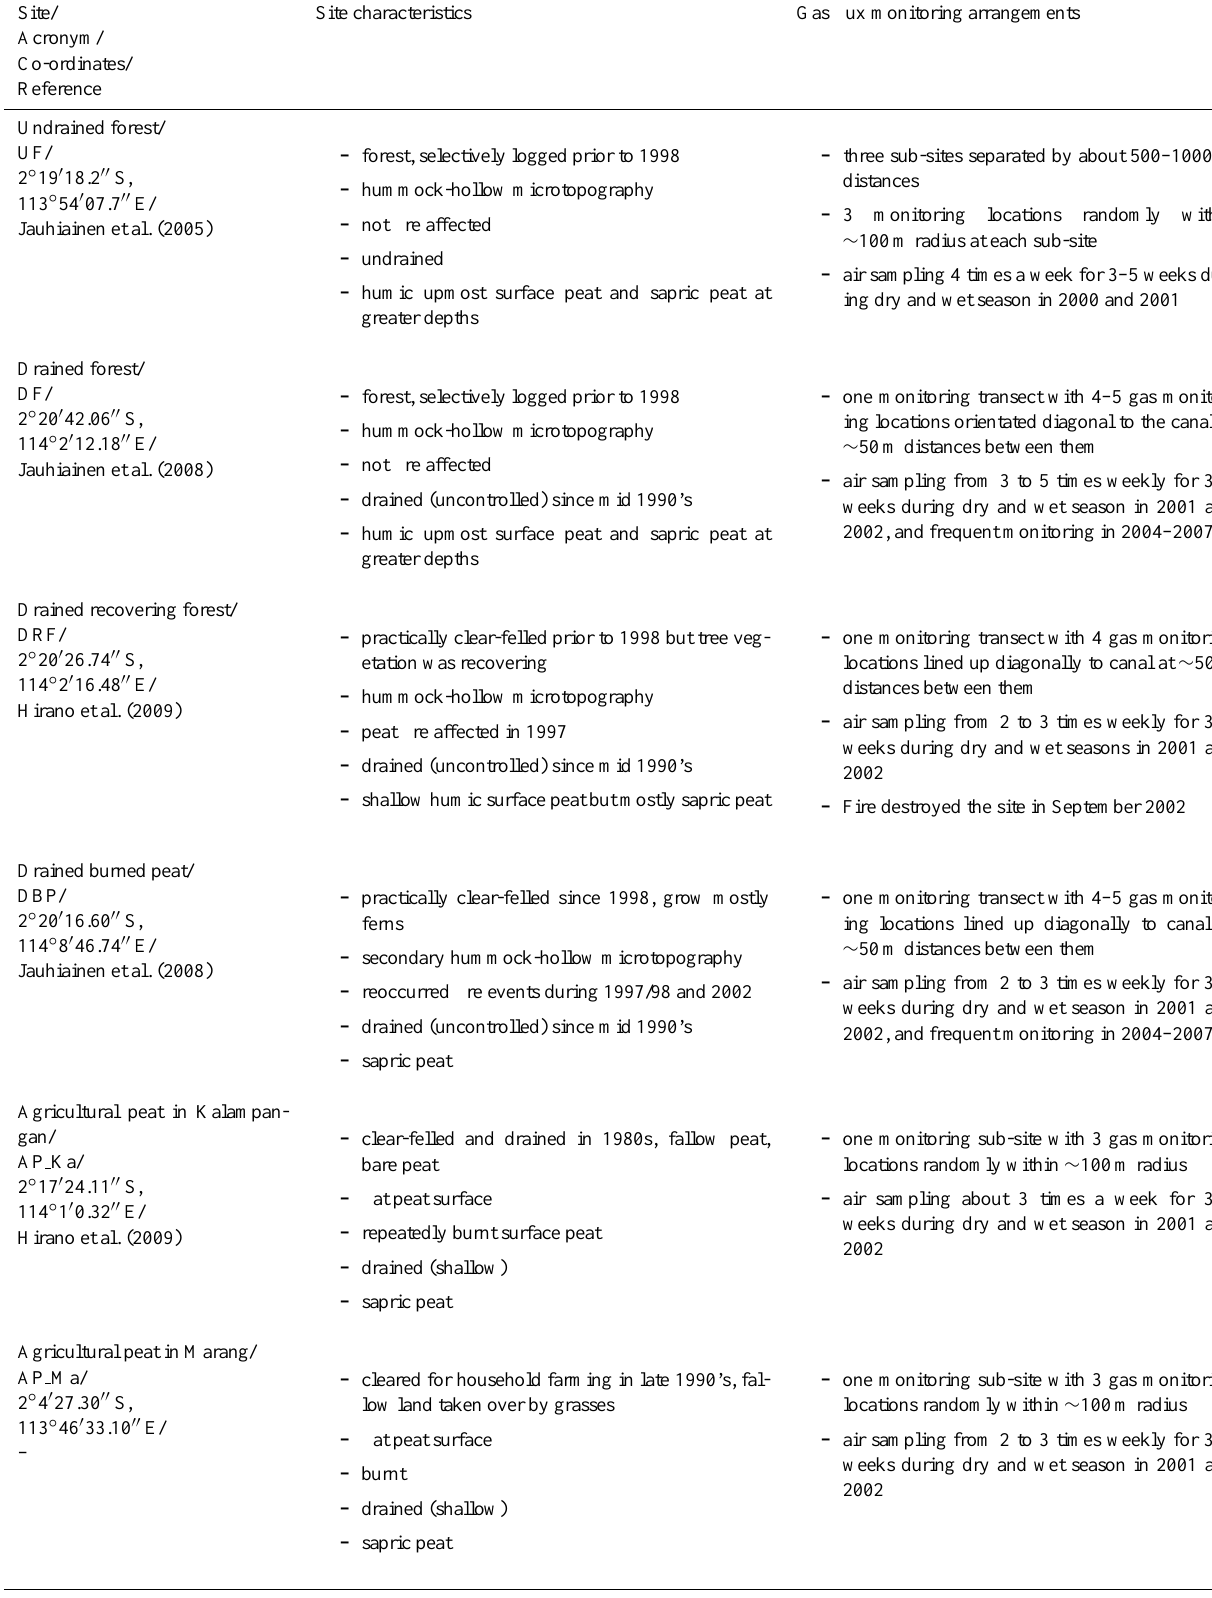
Table 1. Key characteristics of the gas flux monitoring sites, and details of the gas flux sampling regimes used in the